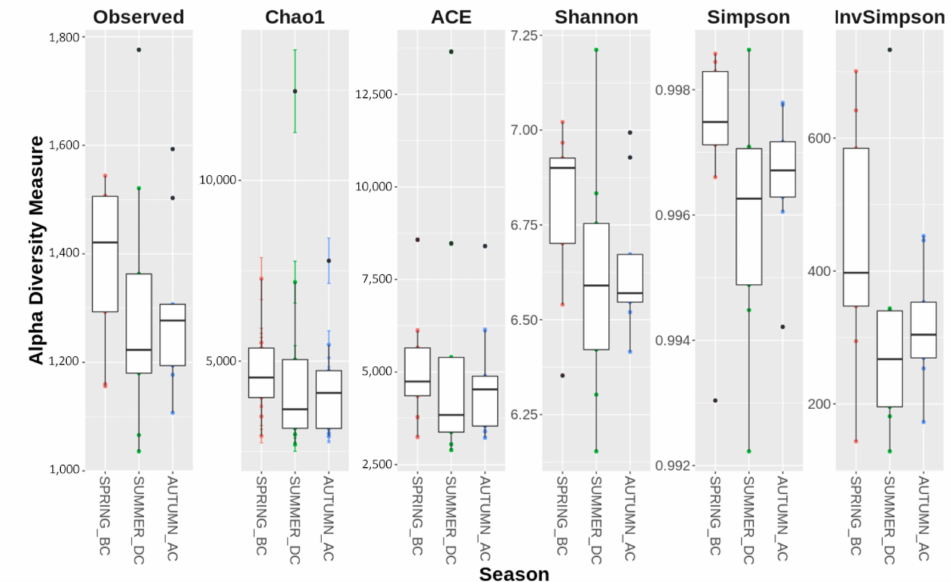
Figure 2. Box-plots of alpha ( α ) diversity indices. The α -diversity of the soil bacterial community as affected by seasonal changes and cultivation period was evaluated using the following indices: Ob- served richness, Chao1, ACE, Shannon, Simpson Index of Diversity and Inverted Simpson (Simpson’s Reciprocal Index). Spring_before cultivation (BC), Summer_during cultivation (DC), Autumn_after cultivation (AC) (number of sites: n = 9). Inferences were made based on the observed trends, yet no significant differences between the seasons were